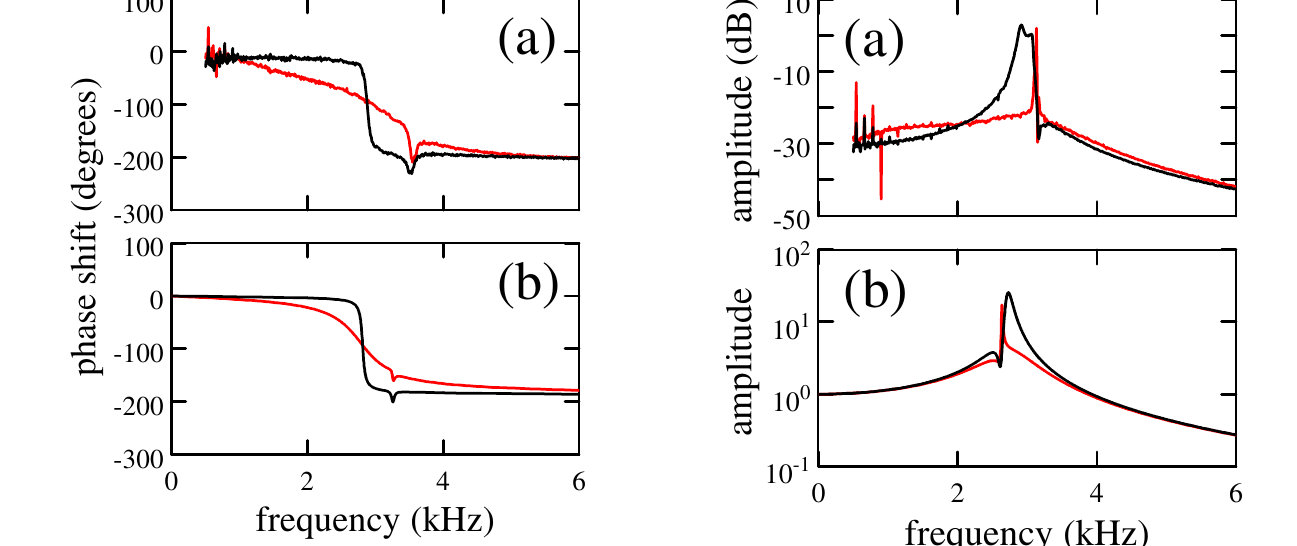
FIG. 7. (Color) Operation with optimal bunch lengthening, where a fast mode-coupling Robinson instability increases the beam’s phase noise and energy spread. Black curves: phase feedback off. Red curves: phase feedback on. (a) Experimental measurement of the transfer function amplitude. (b) Transfer function amplitude calculated with the beam energy spread equaling its natural value.